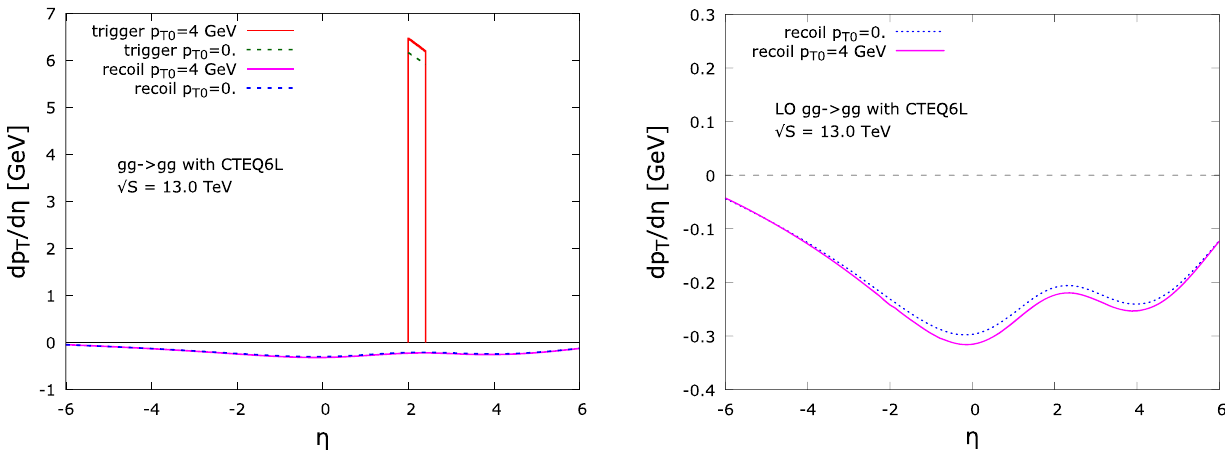
Fig. 4 Left: rapidity correlations (cid:7) p T (cid:8) trig and (cid:7) p T (cid:8) rec from the basic QCD perturbative model with the p T cutoff. The trigger has 2 . 0 < p T < 3 . 0GeV and rapidity 2 . 0 < y < 2 . 4. Right: zoom of the recoil system